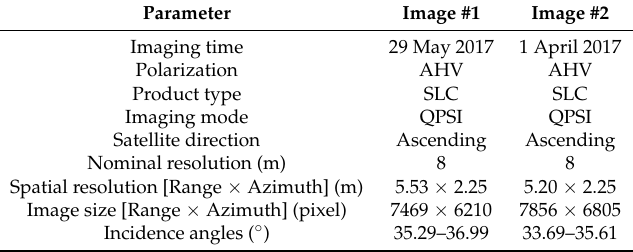
Table 1. Data description of the used GF-3 PolSAR images.